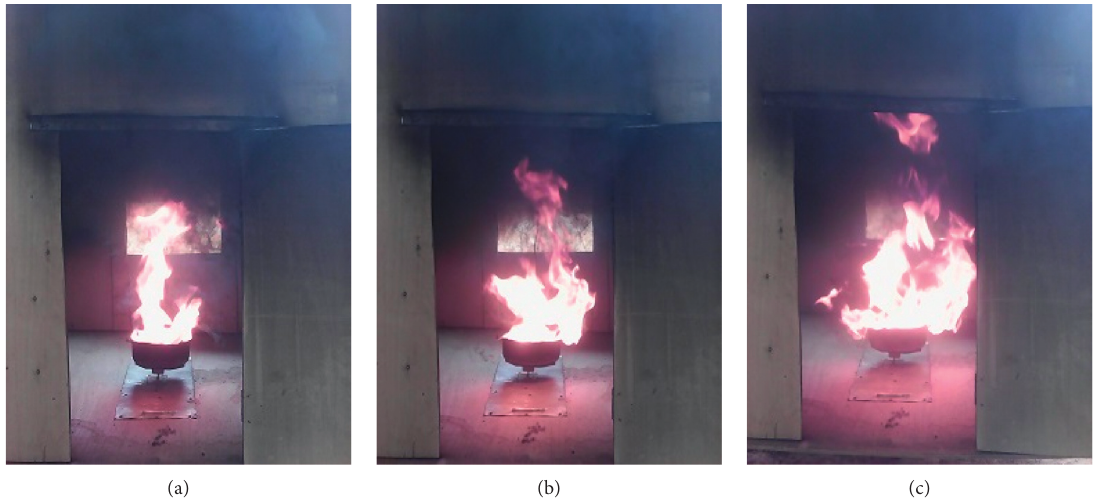
Figure 7: (a) Fire in the PFO configuration at time t time t 0 +20s.